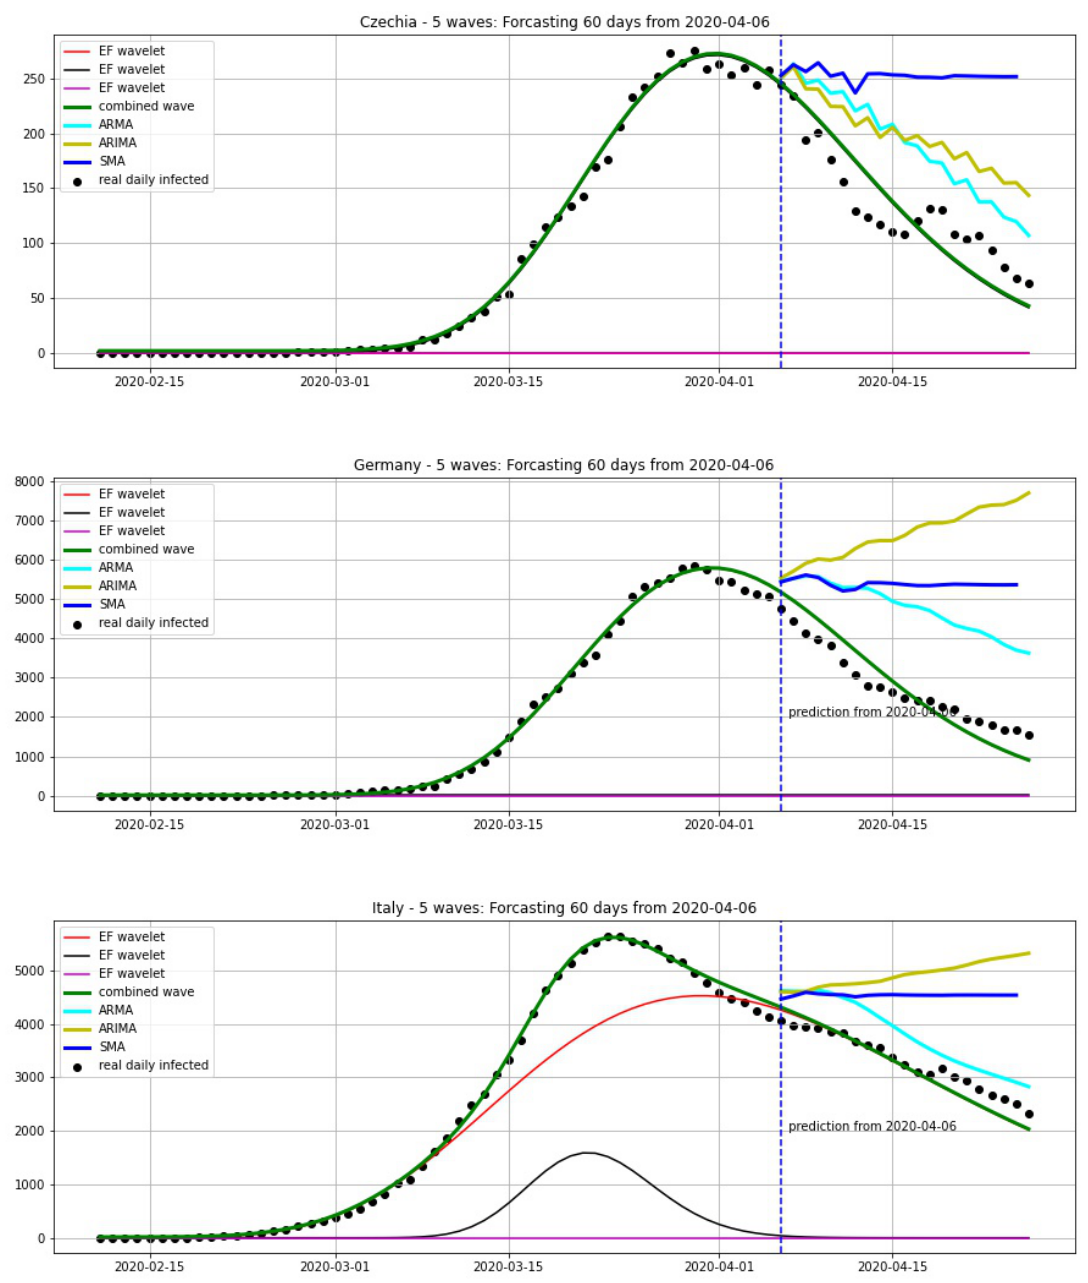
Figure 21. Forecasting 20 days from 06 April, using a wavelet model (green curve) which is combined from EF wavelets, SMA (blue curve), ARMA model (cyan curve) and ARIMA model (yellow curve)